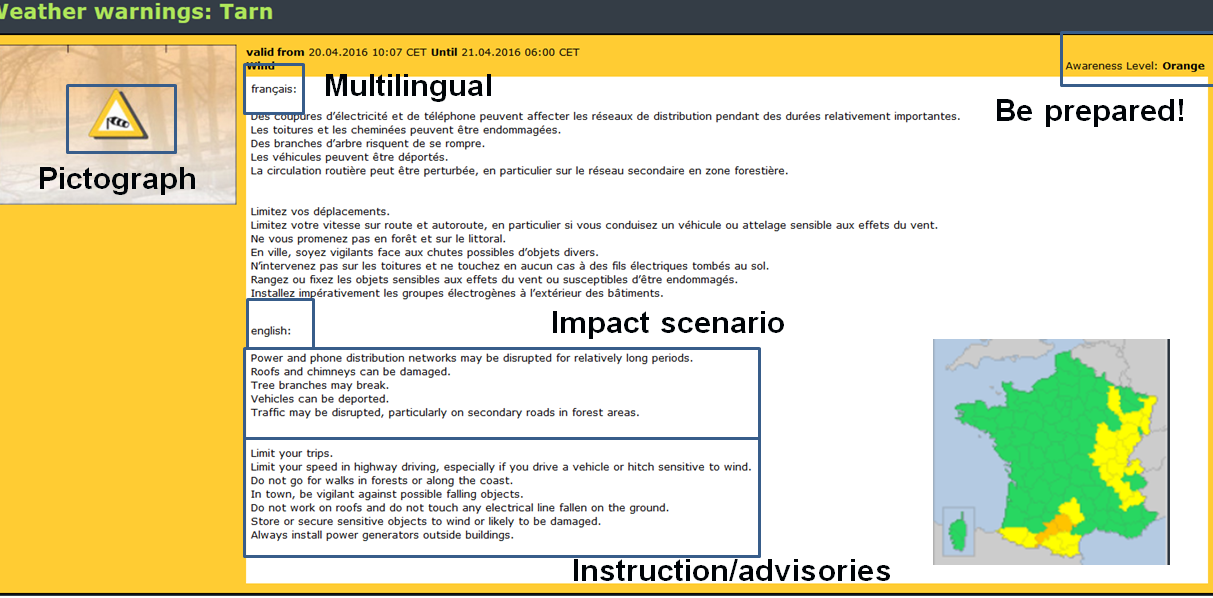
Figure 1. Example of an impact-oriented warning from Météo-France targeting the general public and addressing “What the weather will do”, taken from Meteoalarm (http://meteoalarm.eu, last access: 24 April 2020). As the warning has a tangible and understandable description of an expected damage scenario (information on impacts) and clear advice on what to do (instructions/advisories) it is in alignment with the Sendai